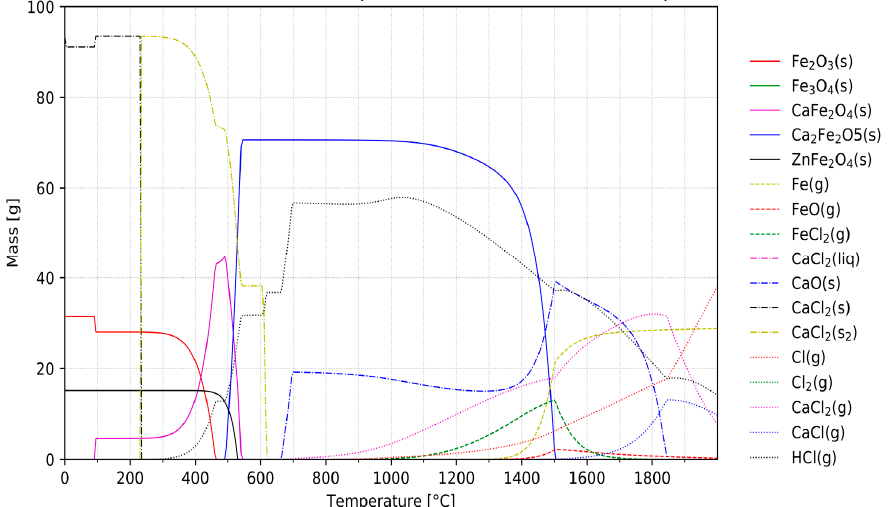
Figure 4. Formation of various solid (solid lines) and gaseous (dashed lines) iron compounds as well as solid (dash dotted) and gaseous (dotted) compounds of CaCl 2 during the chlorination of mock jarosite as a function of temperature .